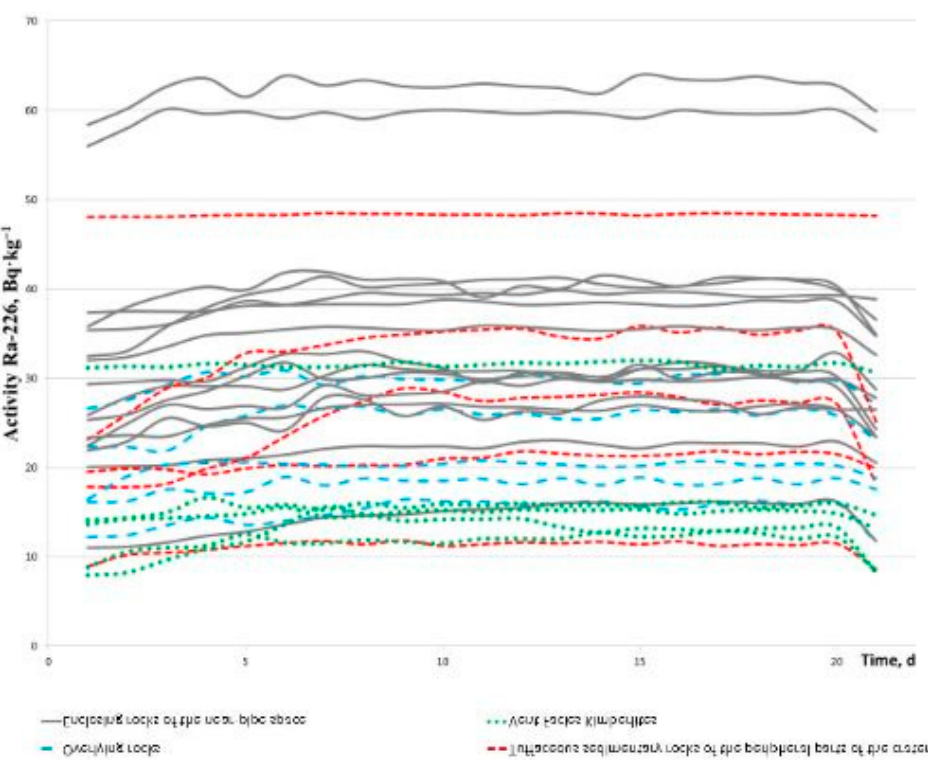
Figure 4. The nature of the distribution of the activity of 226 Ra in time after sealing. Table 2. Results of measurements of radiation and physical characteristics of